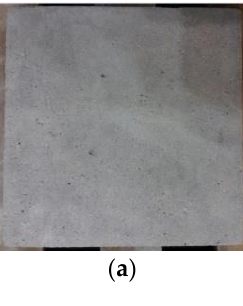
Figure 2. Procedure of ATMS. ( a ) Cleaning surface with sand blasting; ( b ) Surface hardener (SH); ( c ) Surface roughness agent (SRA); ( d ) ATMS. ( c ) Surface roughness agent (SRA); ( d ) ATMS. Table 7. Physical properties of SH and SRA. Table 7. Physical properties of SH and SRA.